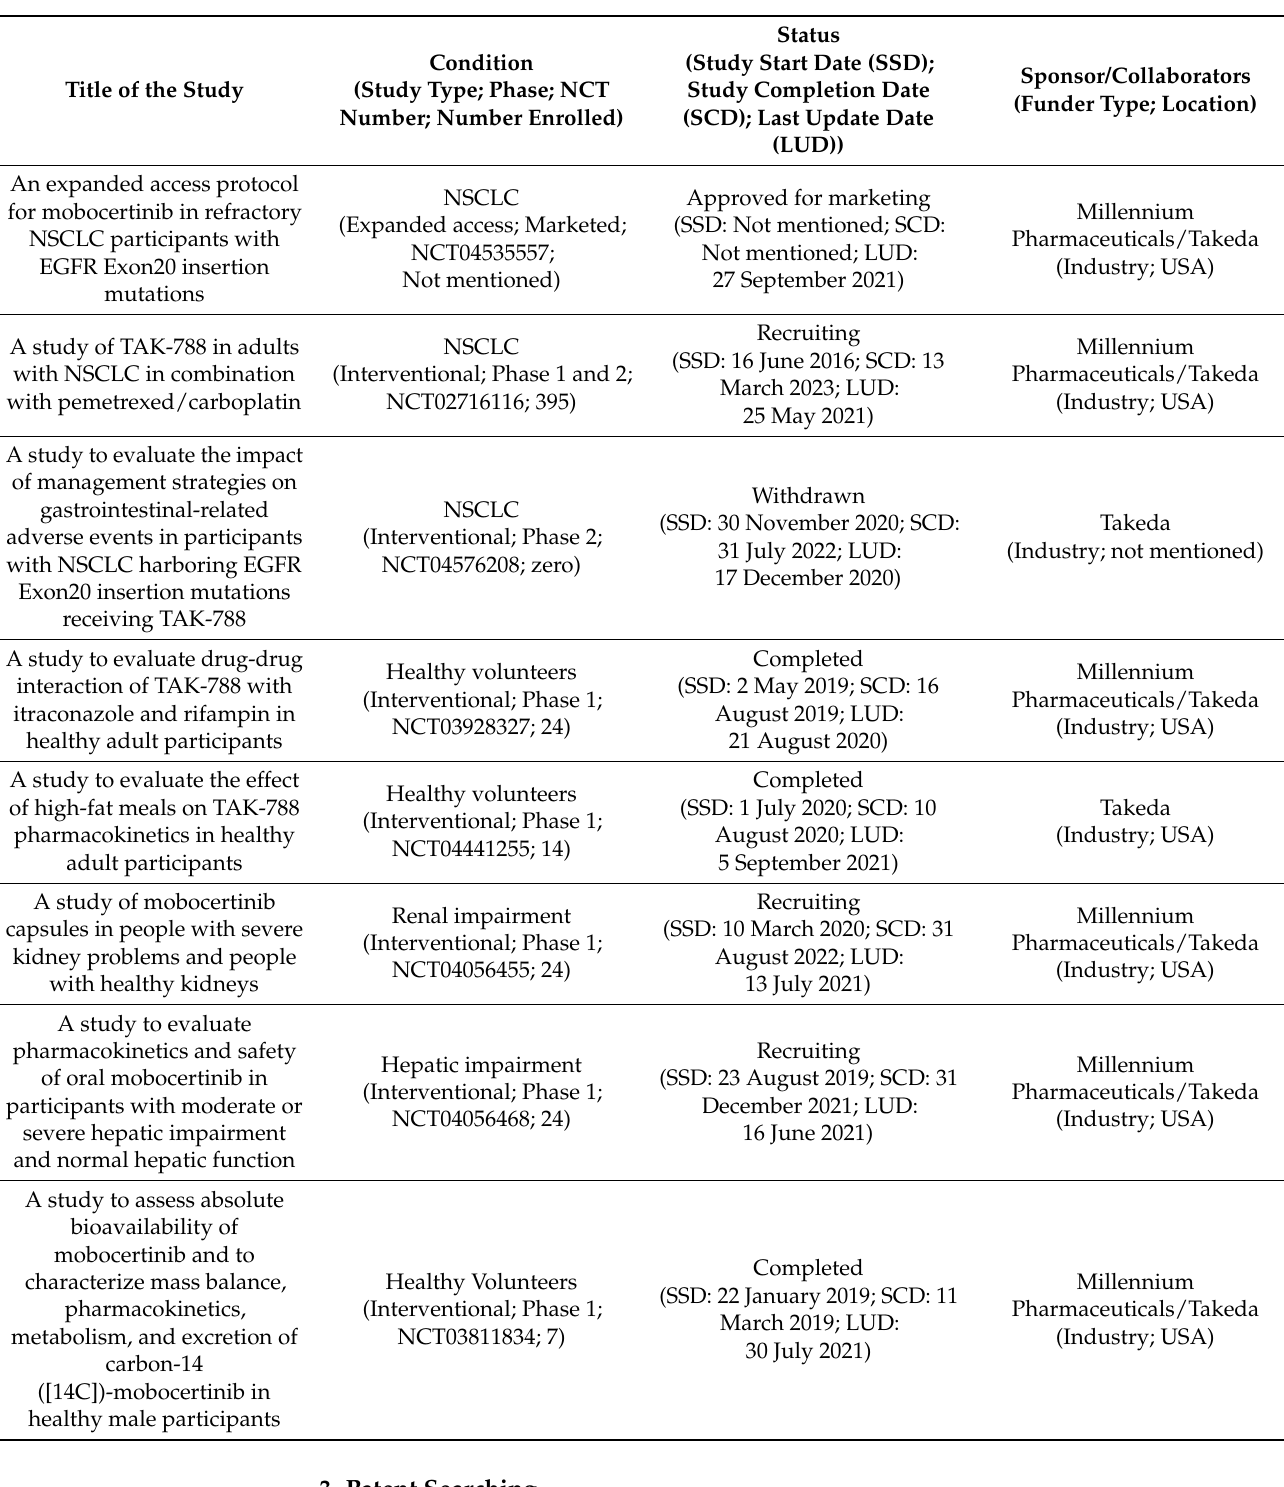
Table 2. Clinical trials on